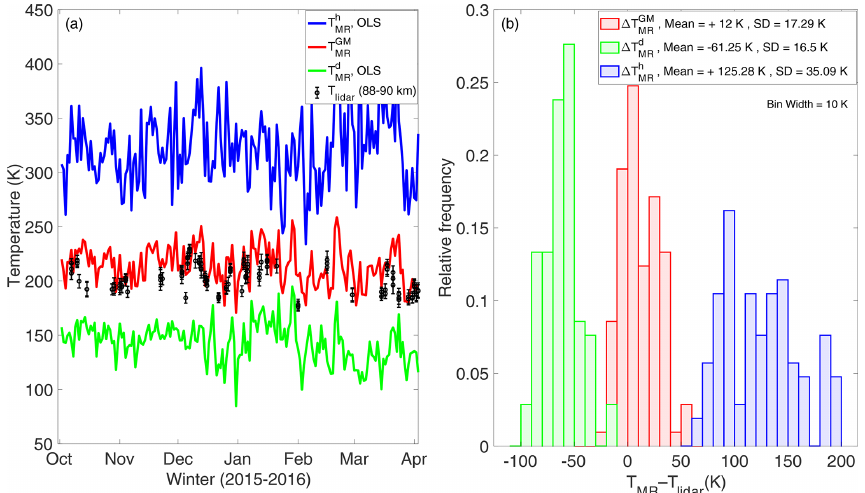
Figure 7. (a) Improved temperature estimation using the GM solution (red) as compared to OLS estimates (blue and green) at contour level 0.4. (b) Reduced mean offset between MR and lidar temperature for GM slope estimate (red) as compared to OLS estimate (green and